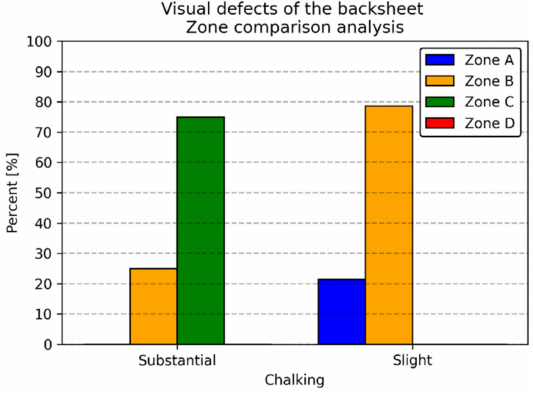
Figure 4. Zone comparison of backsheet